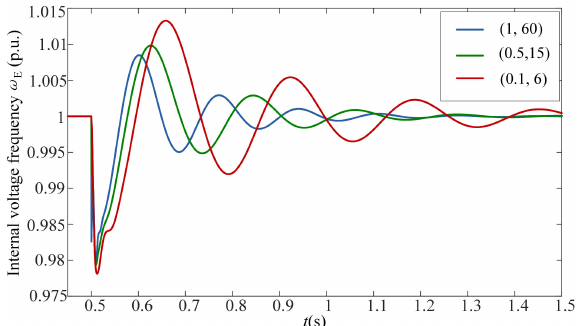
Figure 14. VSC internal voltage frequency dynamics with varied TVC controller parameters ( k p2 , k i2